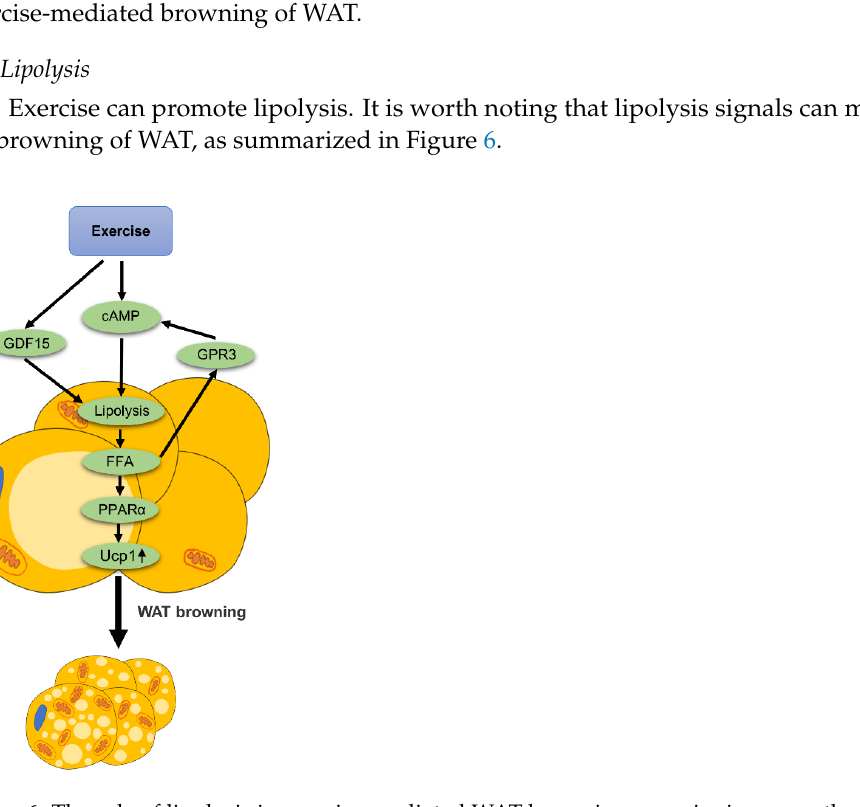
Figure 6. The role of lipolysis in exercise-mediated WAT browning: exercise increases the level of cAMP in adipocytes to promote lipolysis and produce free fatty acids (FFA). Exercise promotes lipolysis of adipose tissue by up-regulating the expression of GDF15. The lipolysis signal directly activates GPR3, thereby promoting the browning of WAT via the cAMP signal. In addition, FFA produced by lipolysis can act as ligands and activates PPAR α . Activation of PPAR α promotes the expression of thermogenic genes such as Ucp1 and mediates the browning of